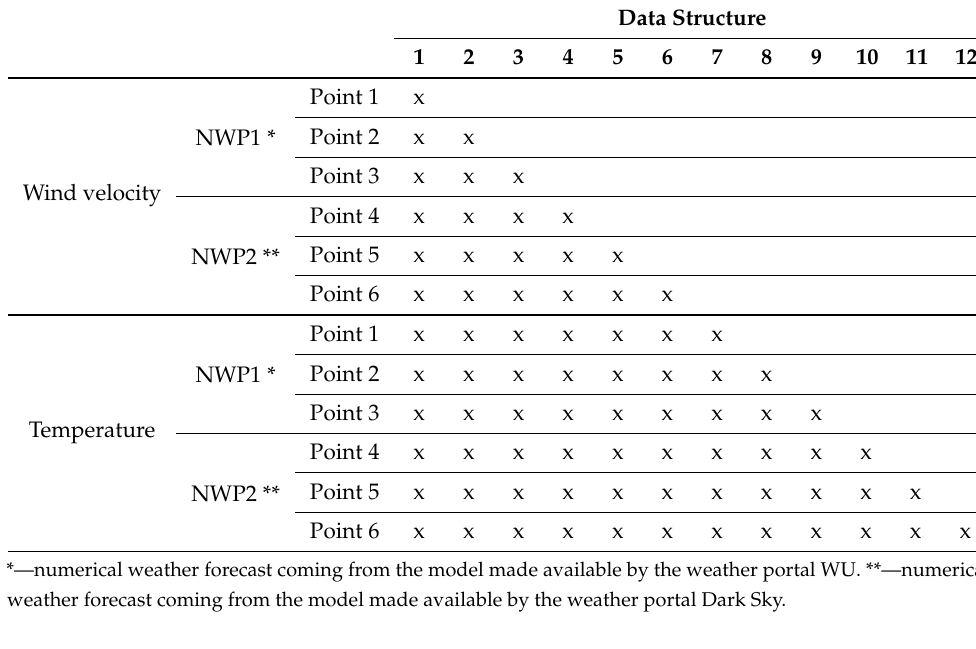
Table 8. Analyzed input data structures, wind power plant FW4.